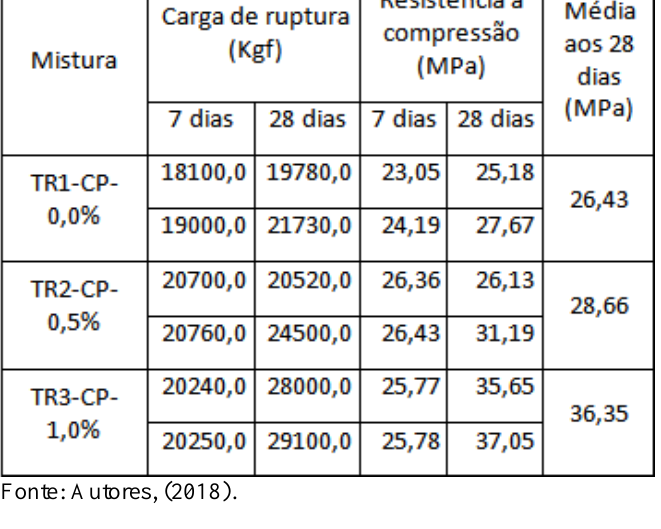
Figura 7: Limpeza dos CP’s para aplicação do indicador químico de fenolftaleína. Fonte: Autores, (2018).